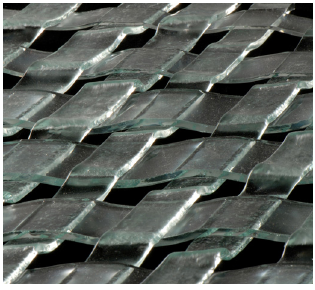
Figure 7: Flexible glass hybrid. Figure 8: Woven